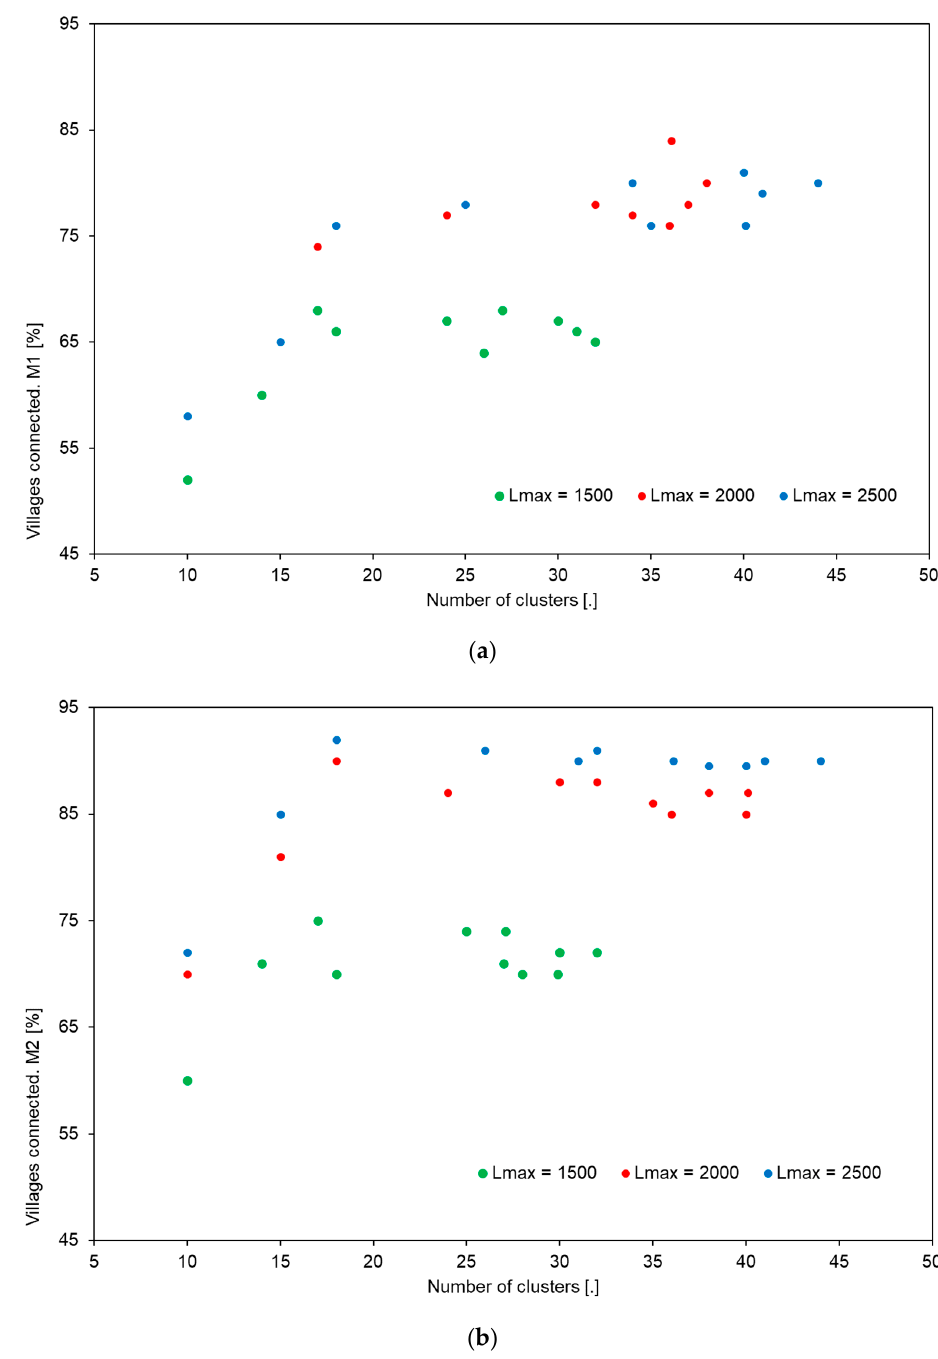
Figure 5. Sensitivity analysis, SA of Poli-ROR against the number of clusters/plants n r , and the maximum length of the transmission line between two villages Lmax . ( a ) Connected villages, Min-LCOE approach M1. ( b ) Connected villages, Max-Connection approach M2.